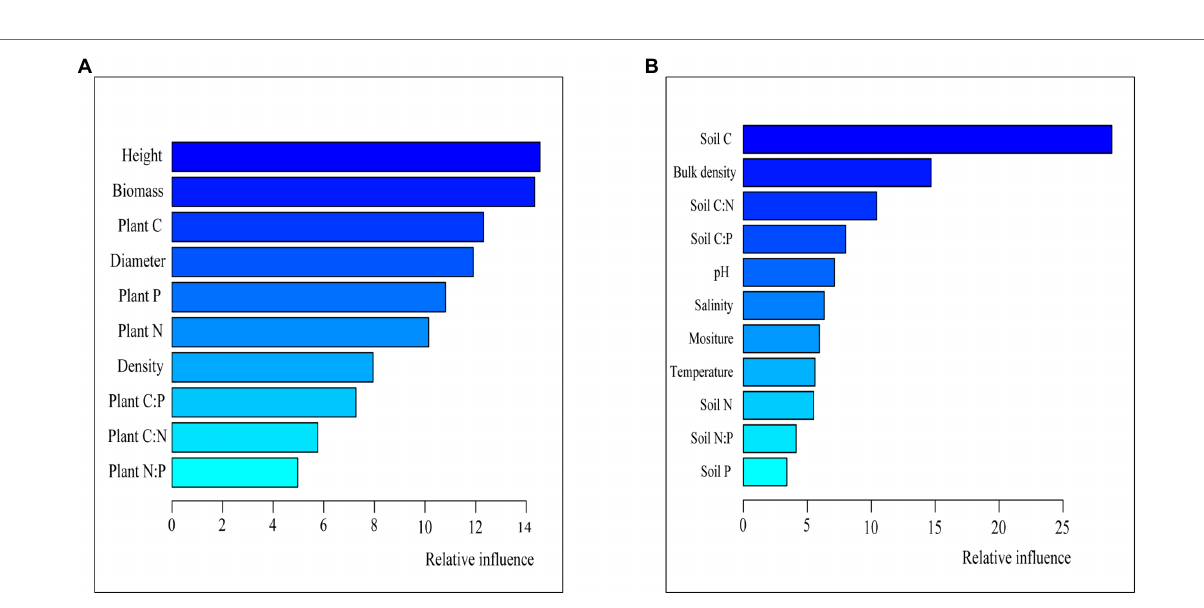
FIGURE 7 | Aggregated boosted tree (ABT) analysis of the soil C, N, and P stocks, plant growth traits, and C–N–P stoichiometry (A) . ABT analysis of the soil C, N, and P stocks, soil physiochemical properties, and C–N–P stoichiometries (B)